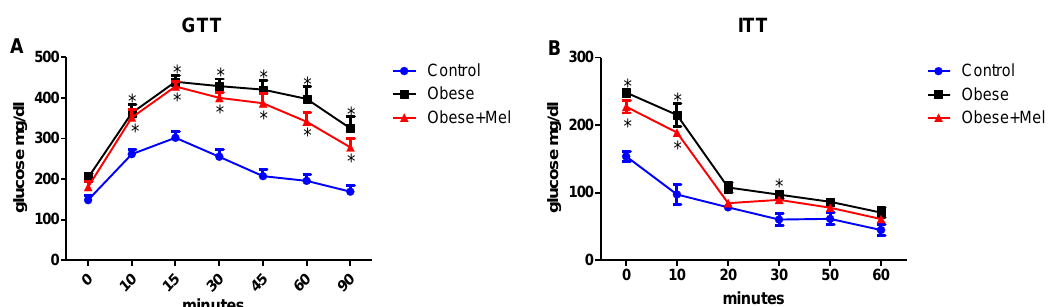
Figure 2. Effects of the high-fat diet (HFD) and melatonin supplementation (Mel, 1 mg/kg b.w., diluted in drinking water, daily, for 10 weeks) on glucose and insulin tolerance tests (GTT and ITT, respectively) in mice. ( A ) GTT or glucose concentration versus time after administration of glucose (2 g/kg b.w.); ( B ) ITT or glucose decay curve versus time after insulin administration (0.75 mU/g b.w.). Values are mean ± SEM (Control n = 11, Obese n = 7; Obese + Mel n = 11). * p < 0.05 versus Control.